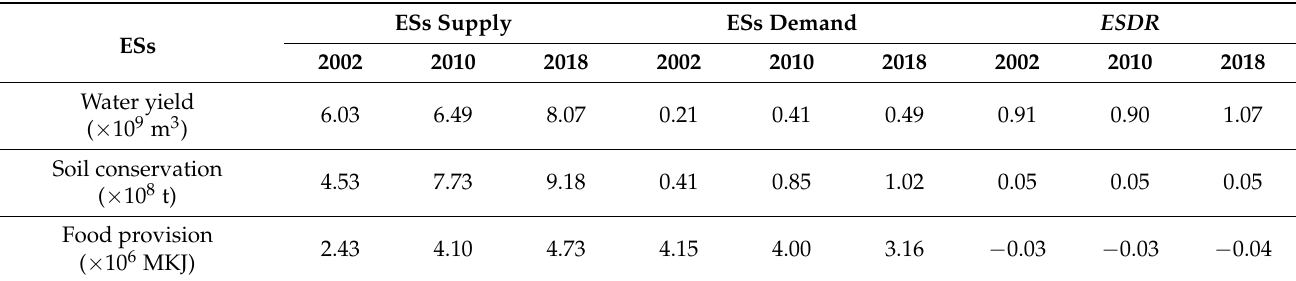
Table 1. ESs supply and demand in the BLJW from 2002 to